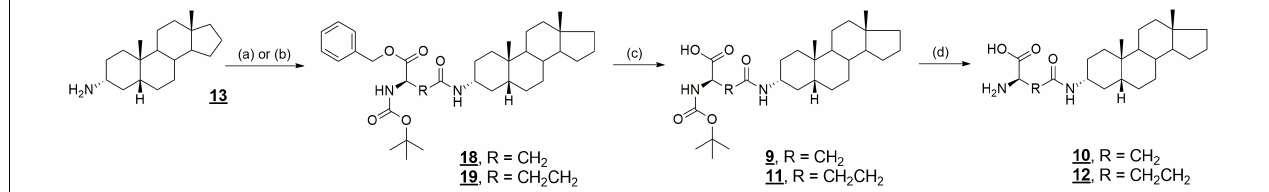
FIGURE 5 | Synthesis of compounds 9–12 and 18, 19. Reagents and conditions: (a) Boc-Asp-OBzl, DIPEA, DMAP, DCC, benzene, rt; (b) Boc-Glu-OBzl, DIPEA, DMAP, DCC, rt; (c) Pd/C, H 2 , EtOH, rt; (d) TFA, CH 2 Cl 2 , rt.